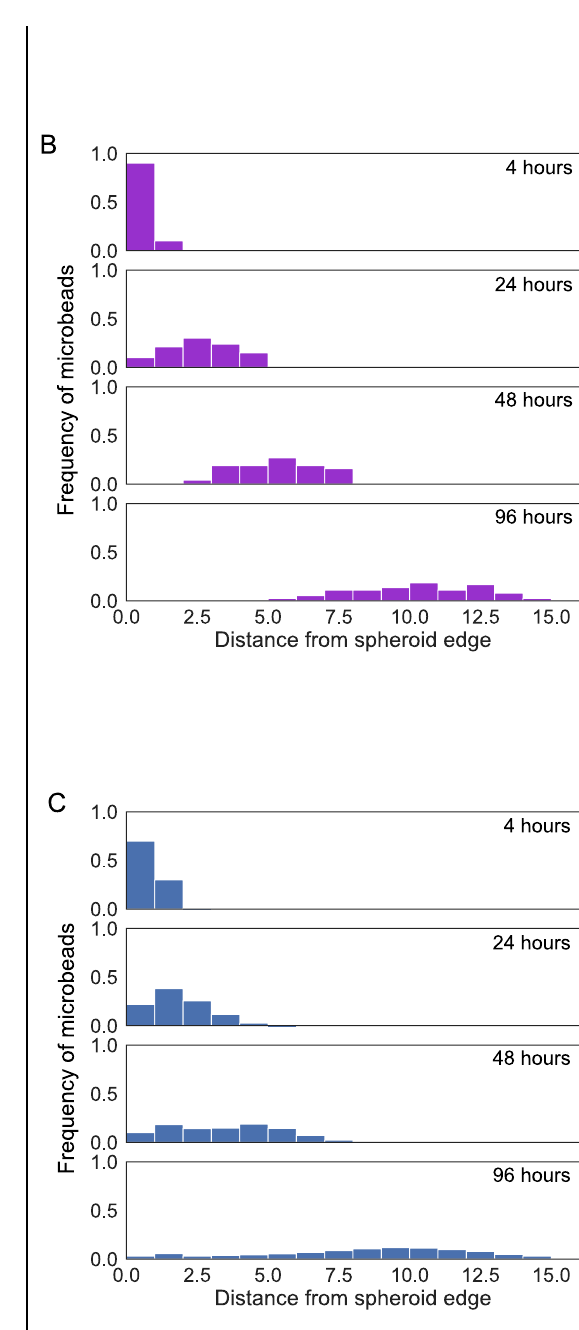
PLOS Computational Biology | https://doi.org/10.1371/journal.pcbi.1007961 August 18, 2020 14 /